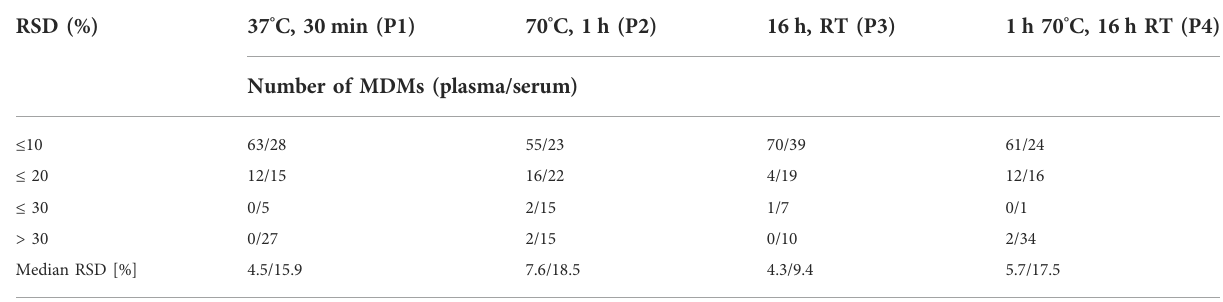
TABLE 4 Comparison of different MeOx conditions based on the repeatability of 75 MDMs detected in both types of samples, in the table was presented number of MDMs with RSD for plasma/serum ≤ 10% – 30% and above